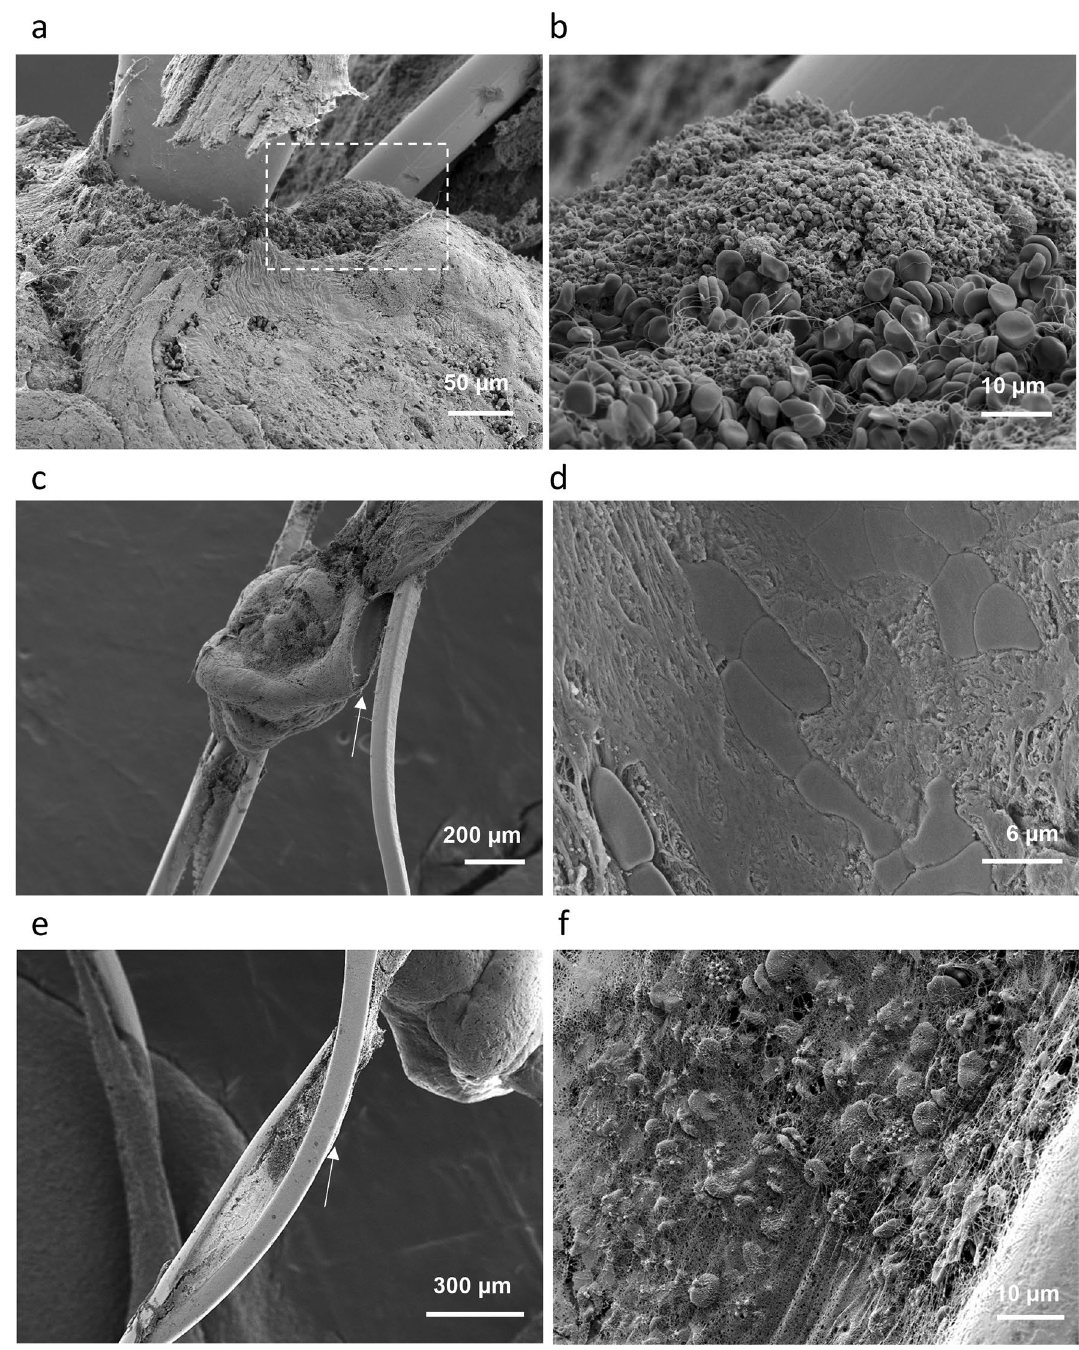
Figure 2. Modalities of RBCs rich thrombus attachment onto the stent. ( a ) Stent strut protruding through thrombus. ( b ) Higher magnification view from ( a ) (dashed rectangle), showing a platelets cap and biconcave RBCs. ( c ) Thrombus conforming with the stent strut. ( d ) Higher magnification view from c (region indicated by arrow), illustrating the thrombus contact area with the stent. ( e ) Bridges of fibrin between the adjacent stent struts. ( f ) High magnification view from ( e ) (region indicated by